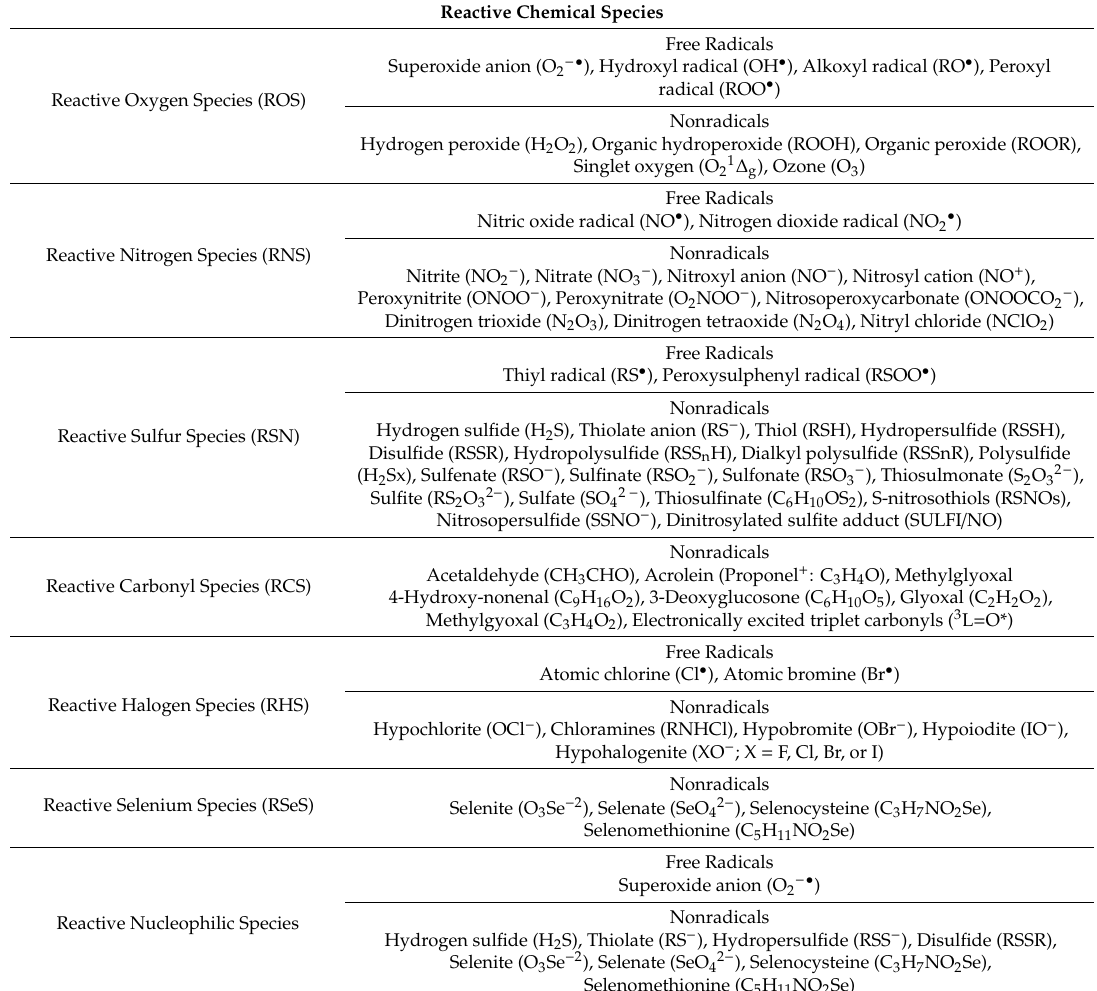
Table 2. Reactive chemical species. During regular cellular activity living cells generate numerous reactive chemical species containing oxygen, nitrogen, sulfur, carbonyl, halogen, or selenium. Reactive sulfur species can contain thiols or nitrothiols. Free radicals possess at least one unpaired electron that makes highly reactive and short-lived. Nonradicals are oxidizing chemicals or easily converted to free radicals. Superoxide, reactive sulfur species, or reactive selenium species can be reducing agents as reactive nucleophilic